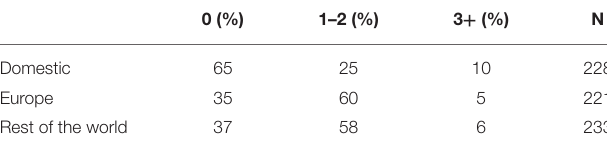
TABLE 5 | Flights per year where the purpose of the flight is